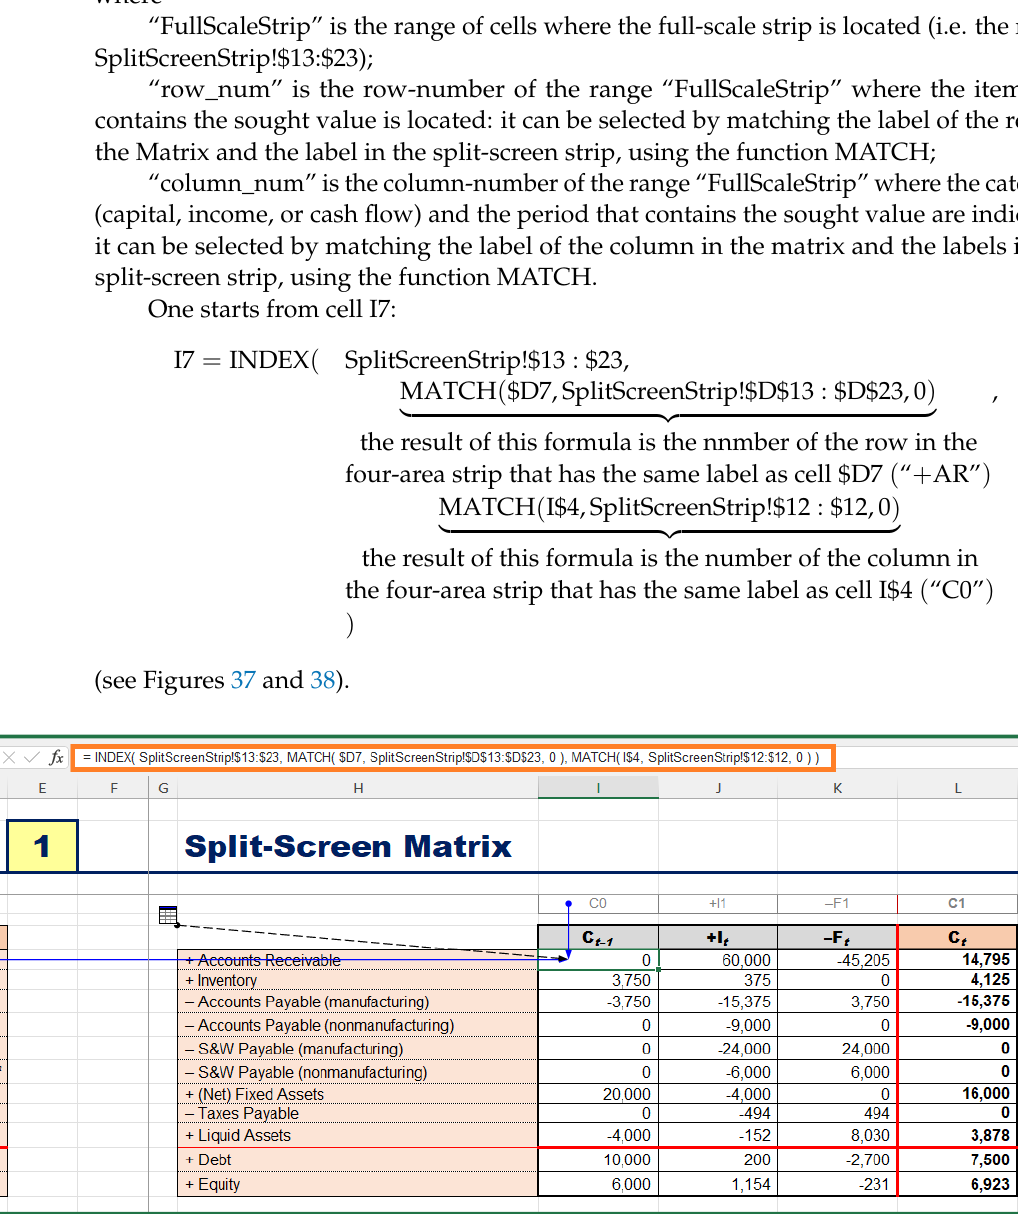
Figure 37. Cell I7 contains the formula for picking up the Account Receivable AR as of period 𝑡 = 0 (“SinglePeriod” sheet).